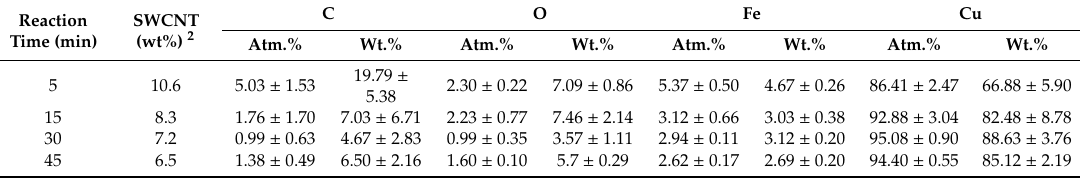
Table 3. Elemental composition (atm.%) of Cu-SWCNT composites prepared by electroless deposition as determined by EDX 1 .